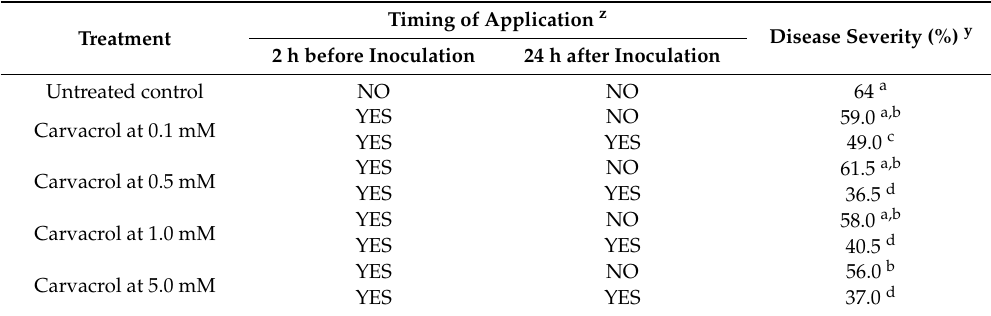
Table 3. Foliar application of carvacrol on squash powdery mildew ( Podosphaera xanthii ) in greenhouse. Treatment